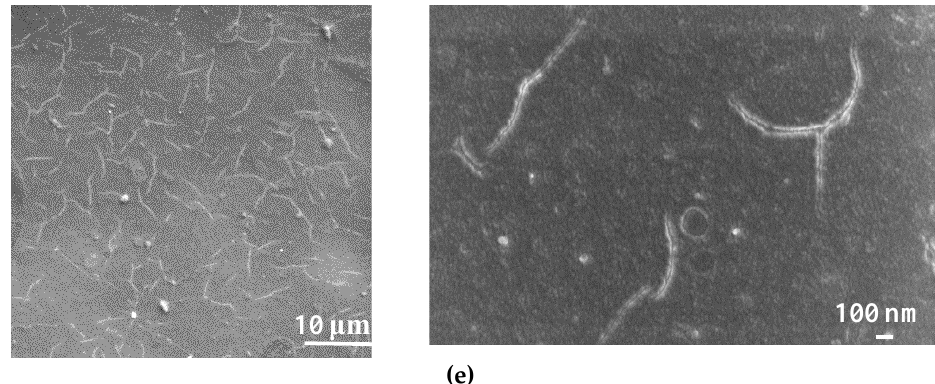
Figure 3. SEM micrographs of the surfaces of the selective layer of the TFC and TFN membranes at lower and higher magnification: ( a ) D0; ( b ) D0-IP; ( c ) D0-IP1; ( d ) D0-IP3; ( e ) D0-IP5.